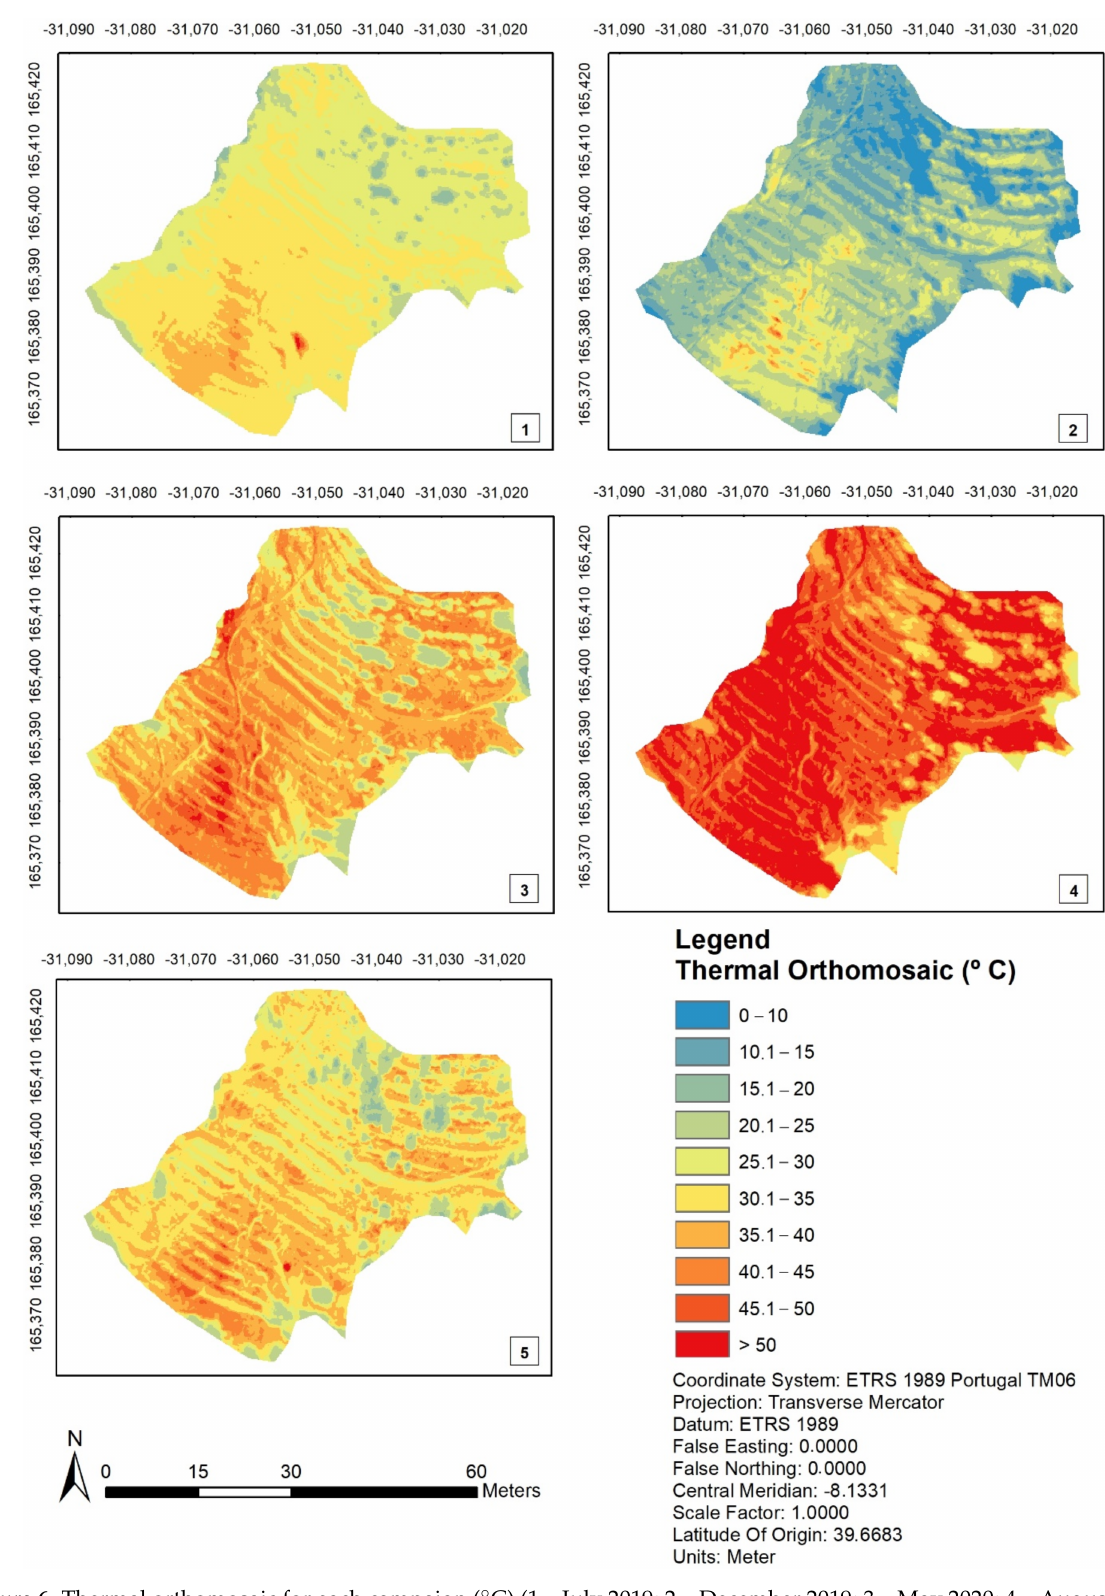
Figure 6. Thermal orthomosaic for each campaign ( ◦ C) (1—July 2019; 2—December 2019; 3—May 2020; 4—August 2020; 5—November